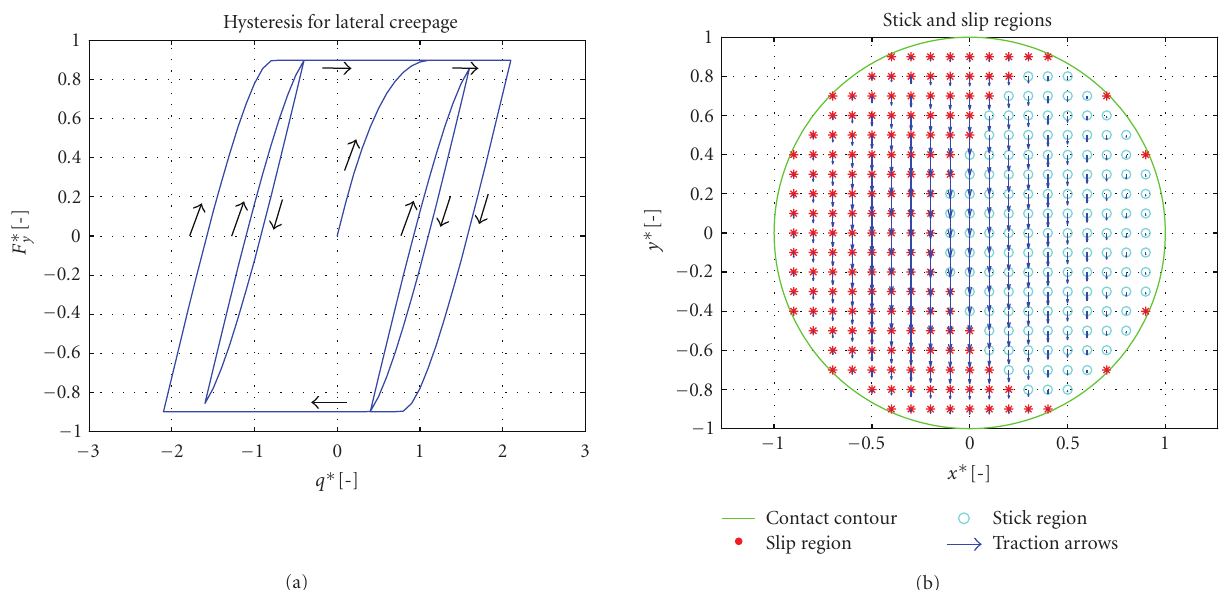
Figure 11: The results for transient (pre-)rolling with lateral creepage. The left panel depicts the hysteresis curve while the right panel visualizes the steady-state rolling traction